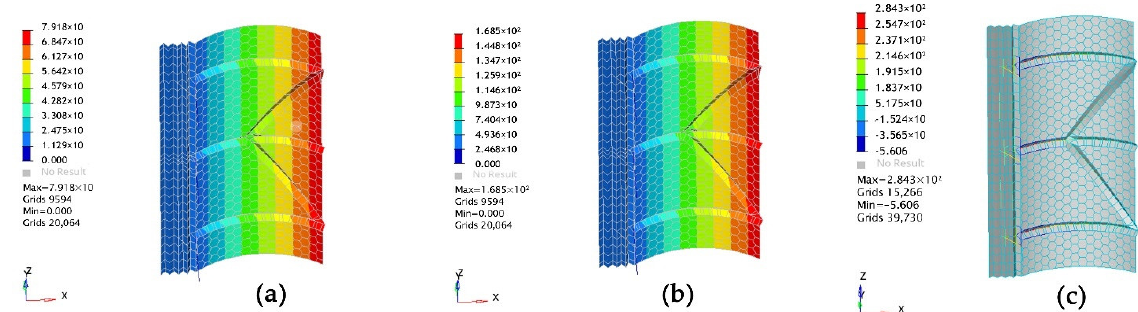
Figure 28. ( a ) Combined displacement clouds under the self-weight of the model one increased column; ( b ) Numerical diagram of deflection under the permanent load plus an external load of the model one increased column; ( c ) Clouds of tensile and compressive stresses under the permanent load plus an external uniform load of the model one increased column.